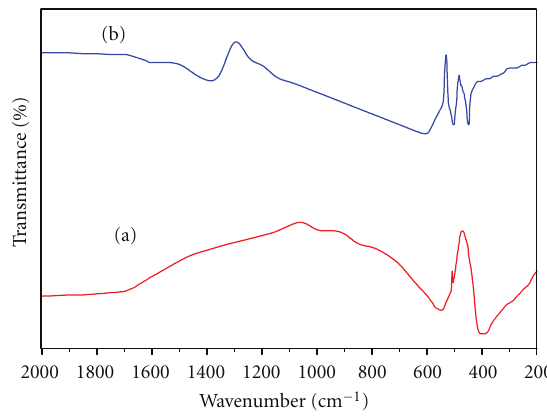
Figure 5: IR absorption spectra of (a) BaTiO 3 and (b) CuO.